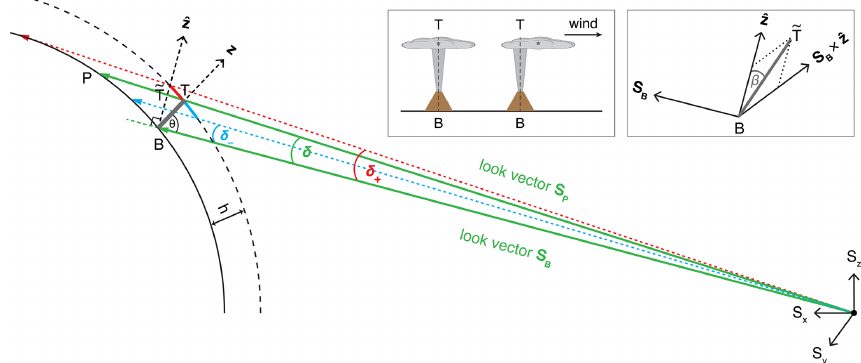
Figure 4. Side view geometry of a vertical column located near the limb as imaged by a geostationary